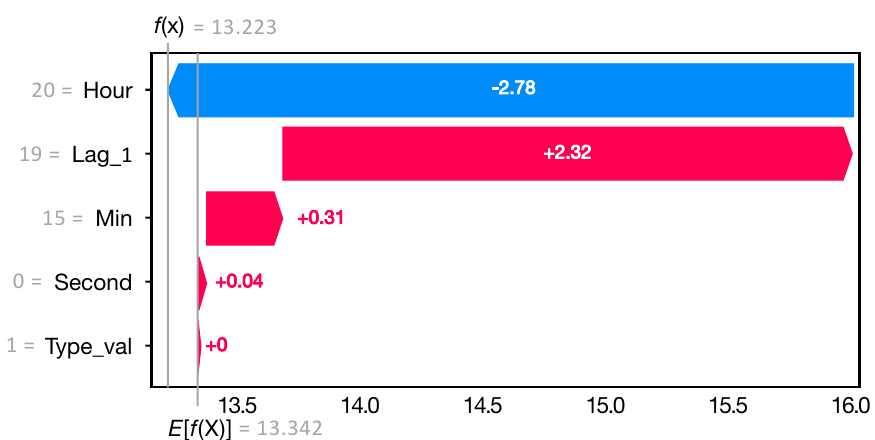
Figure 19. SHAP values for linear regression model to show features’